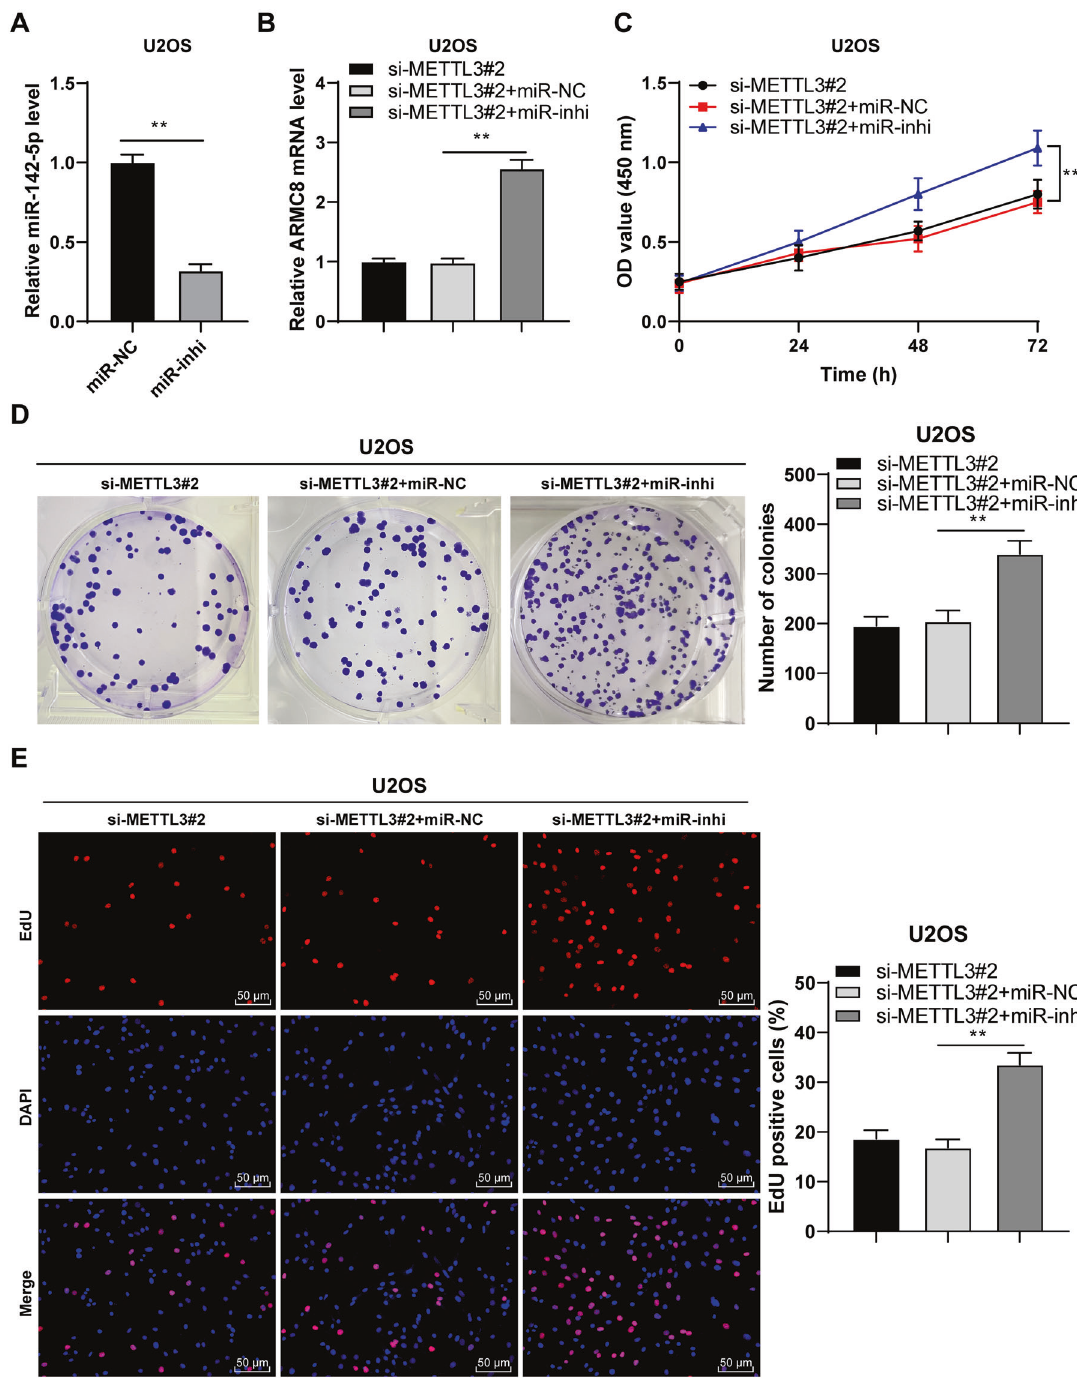
Fig. 7 miR-142-5p silencing reversed the inhibitory effect of METTL3 silencing on OS cell proliferation by upregulating ARMC8 transcription level. miR-142-5p inhibitor (miR-inhi) was transfected into U2OS cells, with miR-NC as negative control. After 48 h, A miR-142-5p expression in U2OS cells was determined using RT-qPCR. Then, miR-142-5p inhibitor-transfected U2OS cells were treated with si-METTL3#2 for 48 h. B ARMC8 mRNA level in cells was detected using RT-qPCR. C – E The proliferation of OS cells was measured using CCK-8 assay ( C ), colony formation assay (14 days) ( D ), and EdU staining ( E ). The cell experiment was repeated three times independently. Data are presented as mean ± standard deviation. Data in panel A were analyzed using t- test. Data in panels B / D , E were analyzed using one-way ANOVA, and data in panel C were analyzed using two-way ANOVA, followed by Tukey ’ s multiple comparisons test, ** p < 0.01. ARMC8 mRNA level on OS cells, but the effect of ARMC8 protein METTL3 on HDAC5, but whether there were other genes regulated level in in vitro experiments is unclear. Finally, whether METTL3 by METTL3 remained unknown. Similarly, the role of other also affected other functions of OS cells, such as migration and downstream genes of HDAC5 and miR-142-5p needed to be EMT, remains further exploration. In the future, we will validate the explored. In addition, this study just explored the impact of Cell Death Discovery (2022)